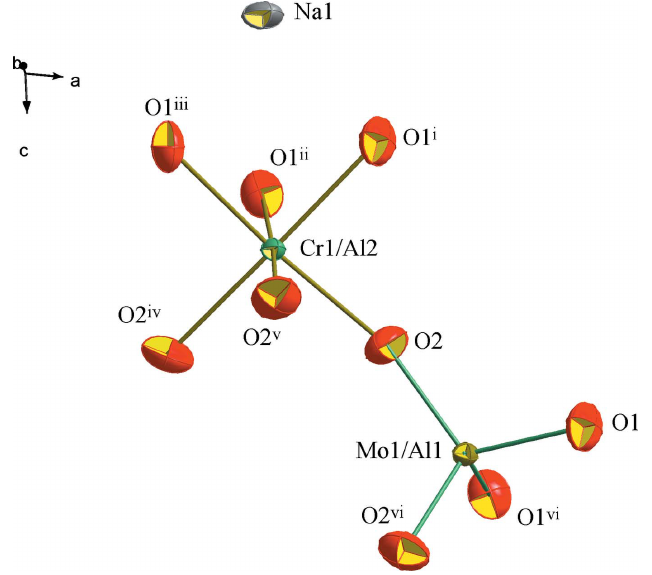
Figure 1 Structural unit of Na 0.72 (Cr 0.48 ,Al 1.52 )(Mo 2.77 ,Al 0.23 )O 12 . Displacement ellipsoids are drawn at the 50% probability level. [Symmetry codes: (i) 2 Figure 4 (cid:5) x , 1 (cid:5) y , 1 (cid:5) z ; (ii) (cid:5) 1 (cid:5) z ; (iii) (cid:5) 1 (cid:5) x + y , 4 (cid:5) z ; + x (cid:5) y , (cid:5) 2 + x , 1 + y , 1 3 3 3 3 3 3 3 3 3 (cid:5) z .] (iv) (cid:5) x + y , (cid:5) x , z ; (v) (cid:5) x , x (cid:5) z , z ; (vi) x (cid:5) y , (cid:5) y , 3 Projection of Na 0.72 (Cr 0.48 ,Al 1.52 )(Mo 2.77 ,Al 0.23 )O 12 along the c 2